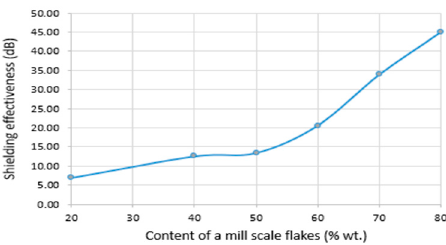
Figure 20. SE dependence of content of iron scale flakes. Frequency—10 GHz.